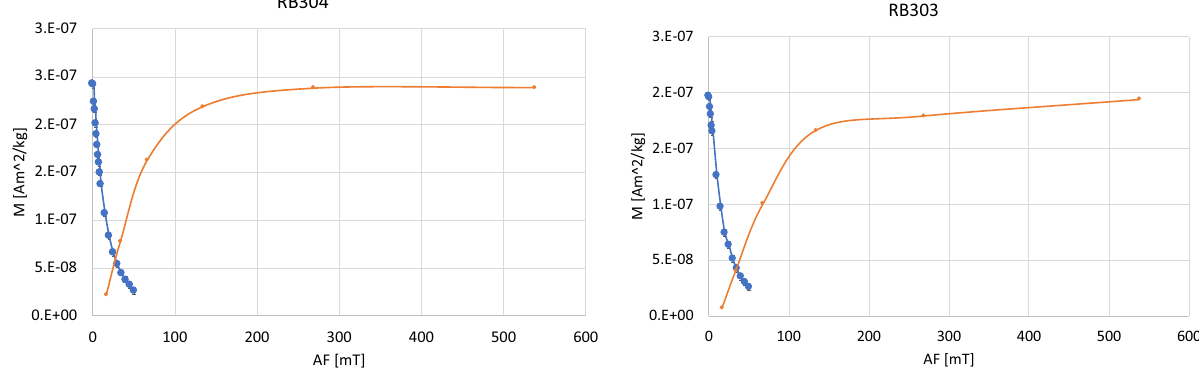
Figure 2. Typical acquisition of magnetic remanence and demagnetization of saturation remanent magnetization of brain B01 samples. Error bars are 2e−9 Am 2